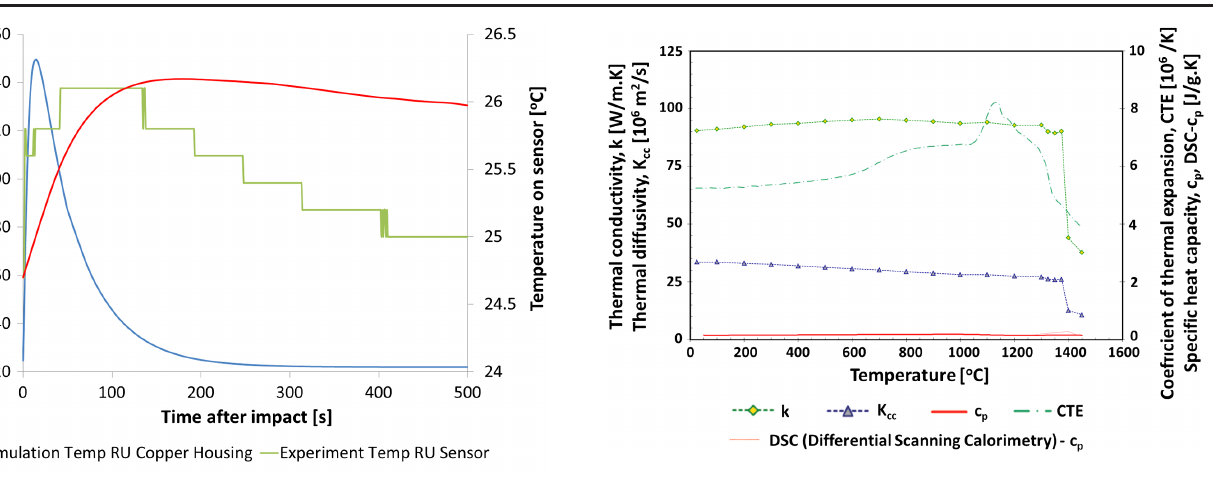
FIG. 20. Thermal properties of Inermet 180 measured up to 1450 °C